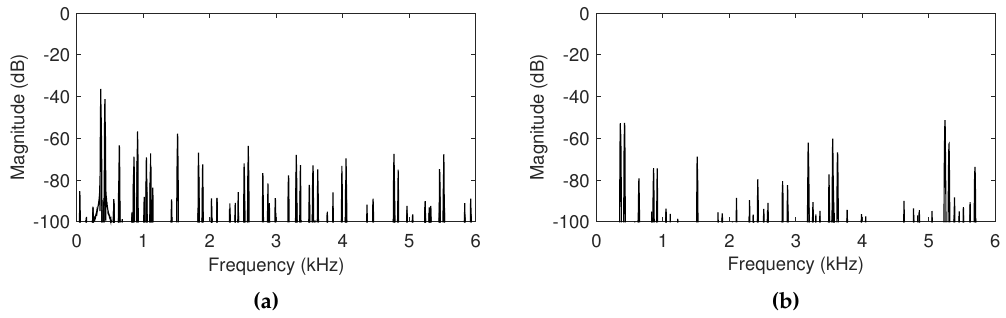
Figure 9. Plots of the magnitude spectrum of the normalized feedback signals when the cutoff frequency of the low-pass filter is ( a ) 300 Hz and ( b ) 6000 Hz. Spectral centroids are 3327 Hz and 3965 Hz respectively. The distance is set to 4 meters.